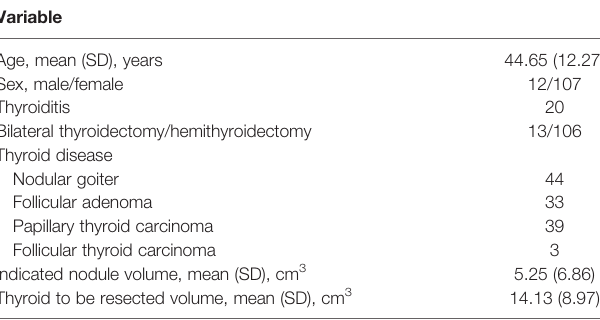
Values are presented as mean/(standard deviation,